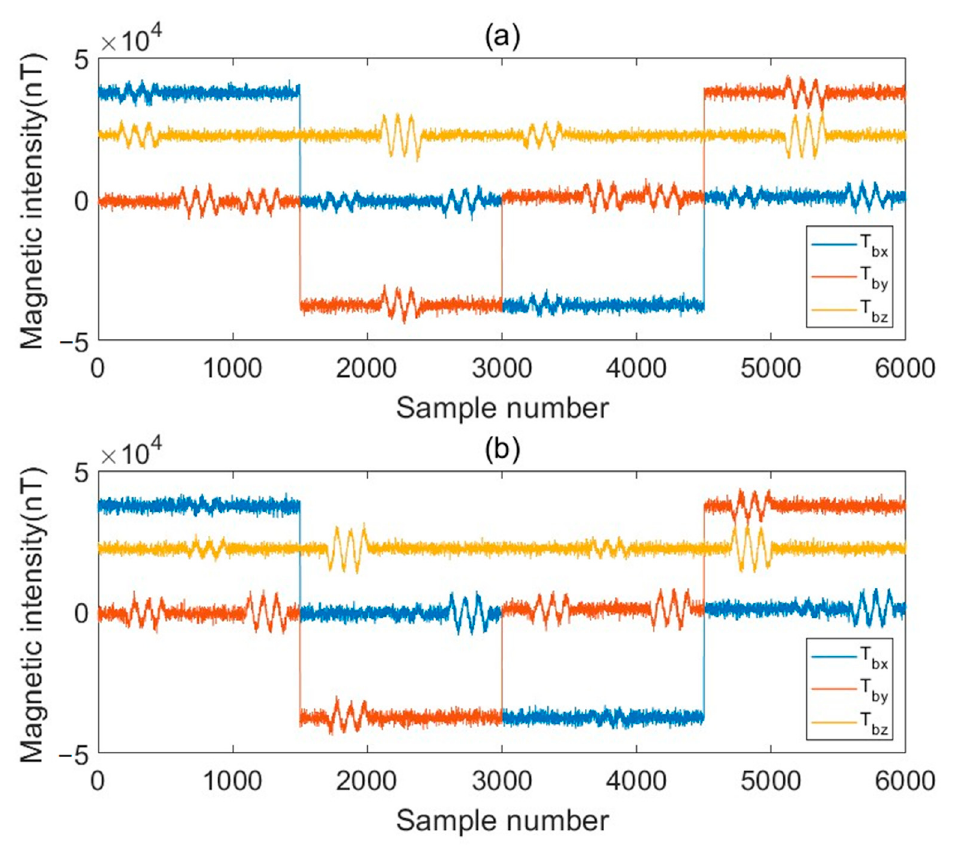
Figure 5. Simulation model of a three-axis fluxgate: ( a ) flight A; and ( b ) flight B.